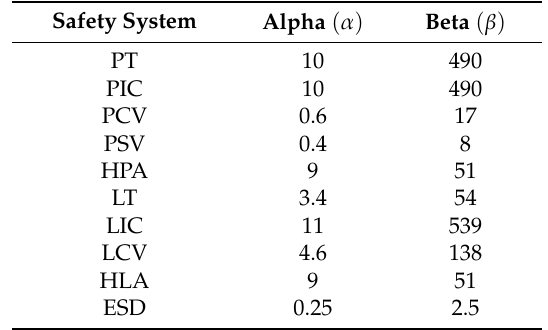
Table 5. Beta distribution parameters for di ff erent safety